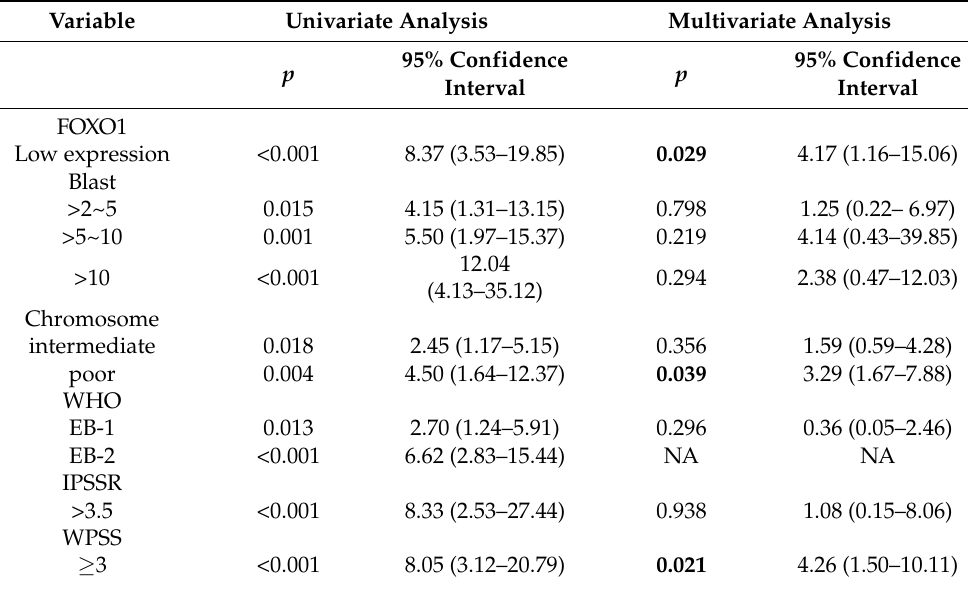
Table 4. Cox regression univariate and multivariate analyses of OS factors in